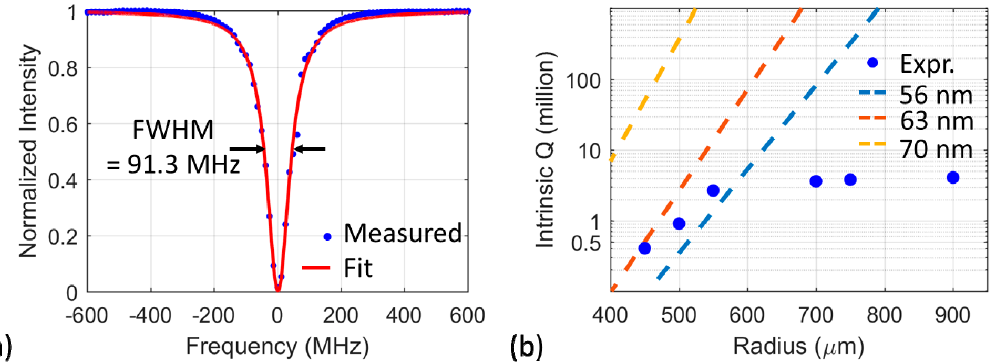
Figure 5. ( a ) Measured spectral responses of the 750 µ m radius Si ring resonator (all-pass configuration) plotted with a Lorentzian fit. The extracted intrinsic quality factor Q int = 4.1 million. ( b ) Simulated bend-loss limited intrinsic Q of the rings versus ring radius at three etch depths. The experimental data of the targeted 56 nm etch depth are depicted as blue circular markers.